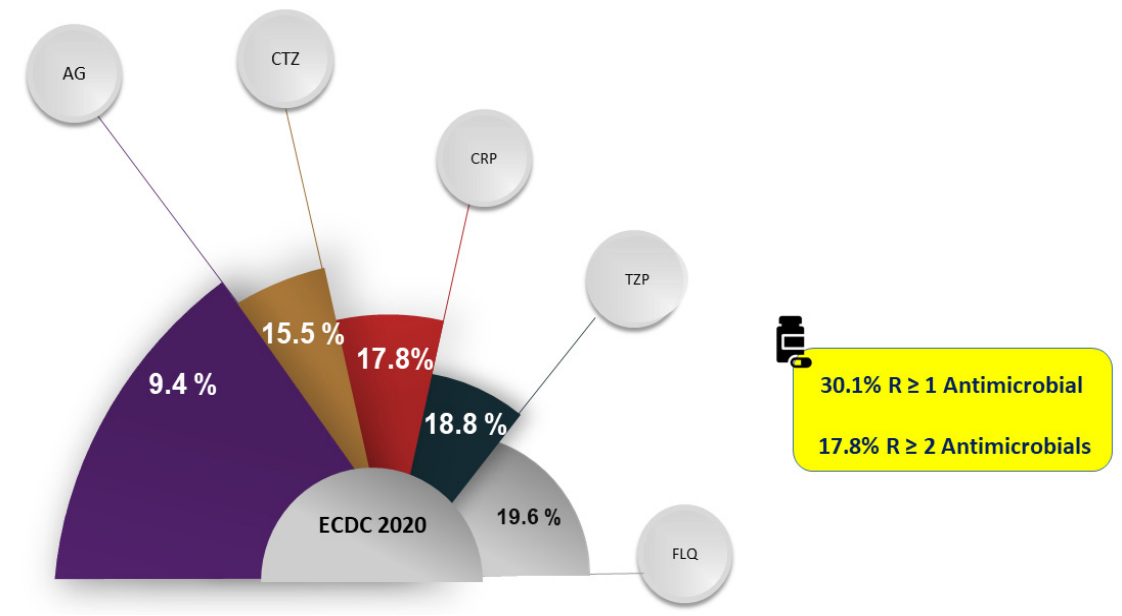
Figure 1. Prevalence of Pseudomonas aeruginosa resistance to common antimicrobials/classes in Europe. Abbreviations: AG, aminoglycosides; CTZ, ceftazidime; CRP, carbapenems; FLQ, fluoroquinolones; TZP, piperacillin-tazobactam; R, resistant, ECDC, European Centre for Disease Prevention and Control; R, resistant [12].